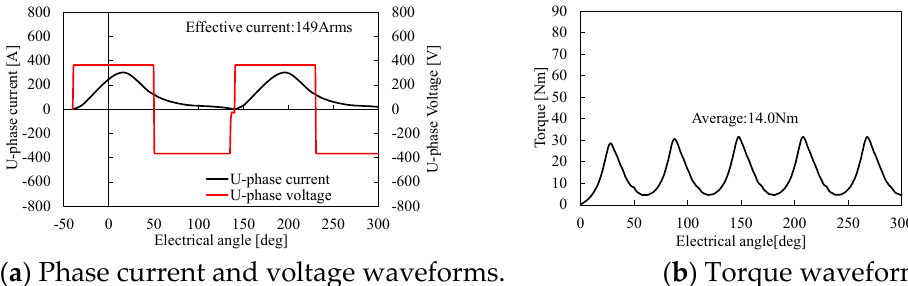
Figure 14. Rotation speed of 52,000 min -1 , turn-on angle of − 40 degrees, and turn-off angle of 51 degrees.